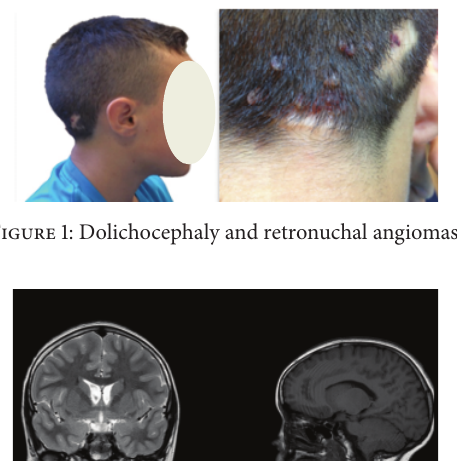
Figure 3: Surgical specimen.